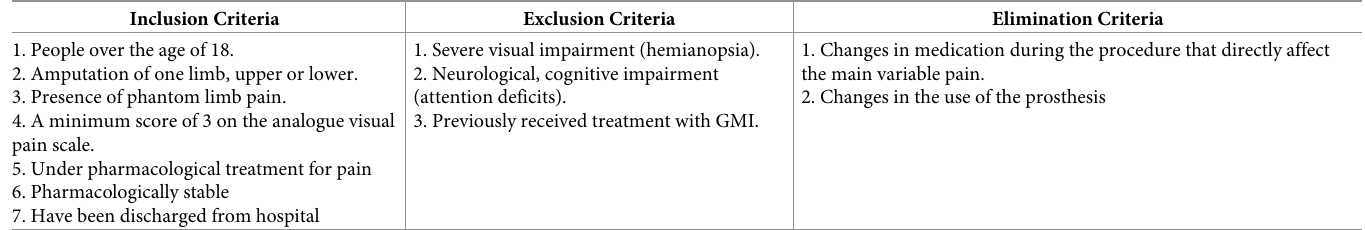
Table 1. Trial inclusion, exclusion and elimination